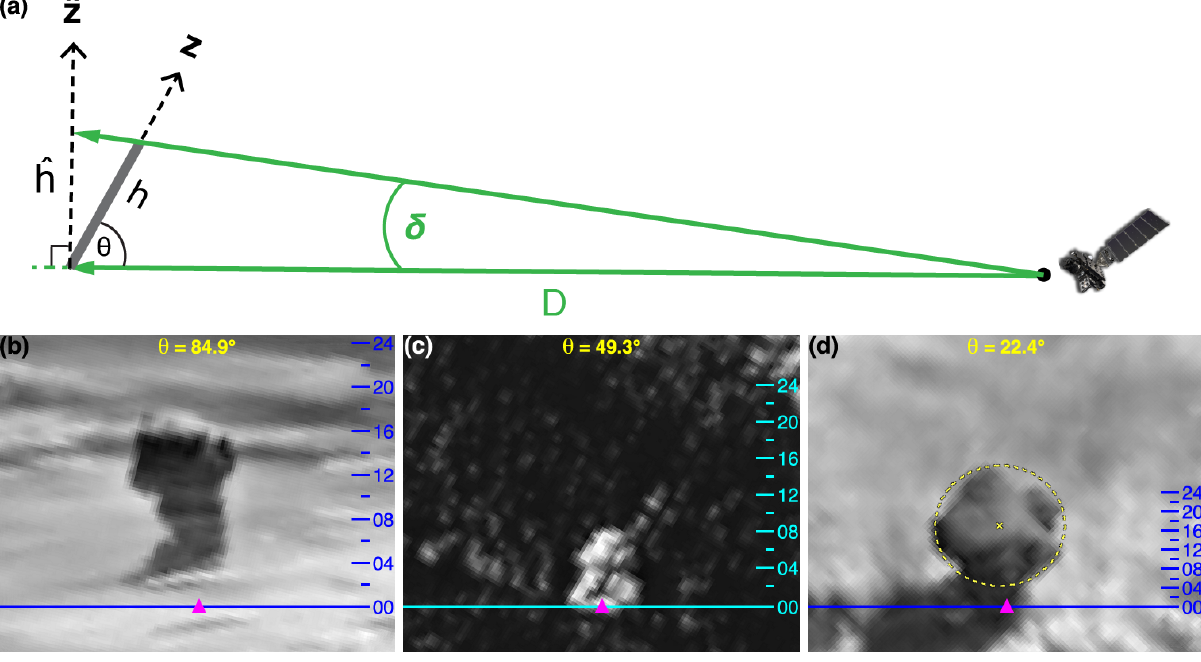
Figure 2. Side view measurement principle and increase of foreshortening at smaller view zenith angles. (a) The z axis is the local vertical and the ˆ z axis is perpendicular to the sensor-to-volcano look vector. The true height and the apparent (foreshortened) height of the eruption column are h and ˆ h , respectively. The angular extent of the column is δ , as measured from a distance D and at a view zenith angle of θ . Examples of eruption columns observed in channel 2 visible images (8 × magnification) at decreasing θ : (b) La Soufrière, 11 April 2021 at 13:30UTC by GOES-17; (c) Hunga Tonga-Hunga Ha’apai, 19 December 2021 at 20:30UTC by GOES-17; and (d) is the same as (b) but by GOES-16. The volcano is marked by the magenta triangle and the elevation markings indicate the true height in kilometers. In panel (d) , the dashed yellow line is a circle of 5.2km radius fitted to the